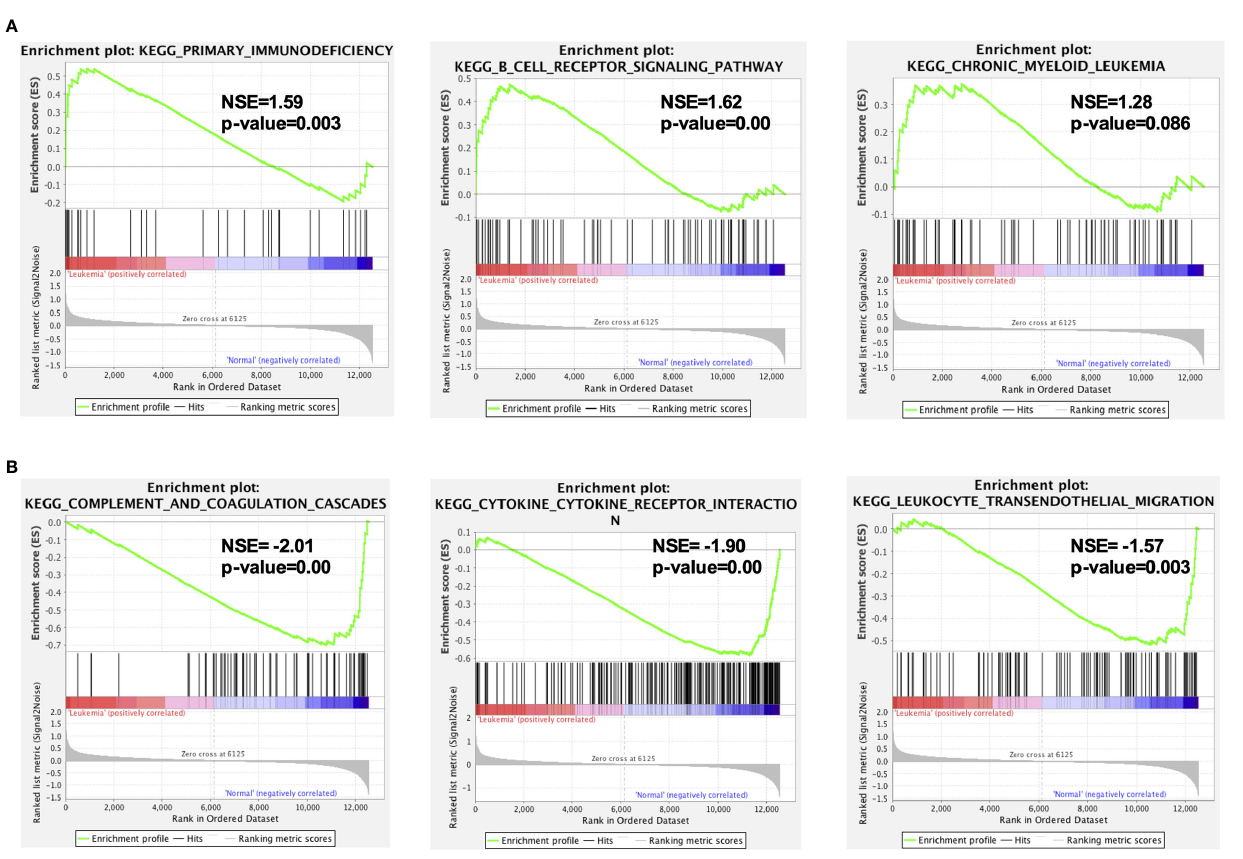
FIGURE 3 | GSEA indicated the KEGG pathways in MLL -r ALL. (A) The gene sets enriched in MLL -r ALL samples were related to primary immunode fi ciency and B- cell receptor signaling pathway ( p < 0.05). (B) The gene sets enriched in normal samples were mainly related to complement and coagulation cascades, cytokine – cytokine receptor interaction, and leukocyte transendothelial migration ( p <